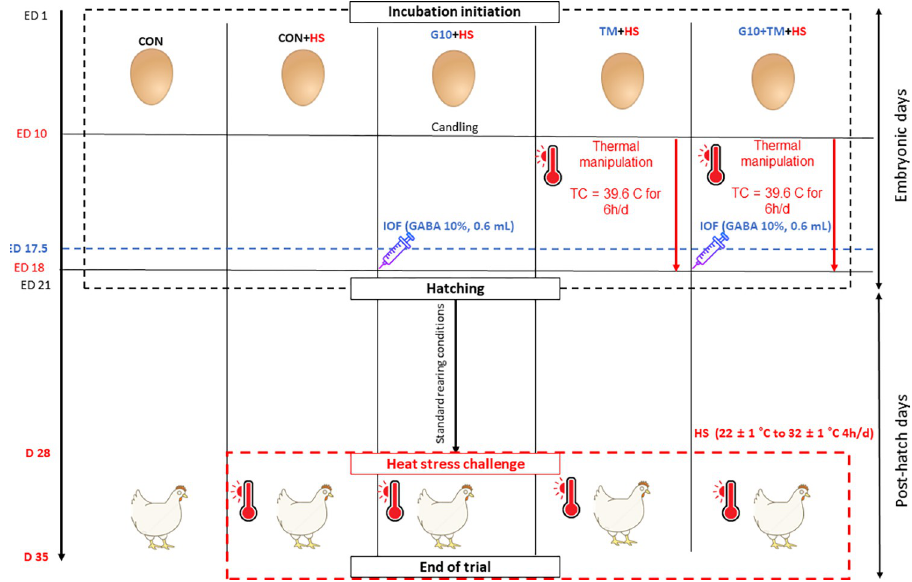
Fig 1. Study design. The treatments are described as follows: CON, chicks hatched from control eggs without in ovo injection and incubated at standard temperature; CON+HS, chicks hatched from control eggs without in ovo injection, incubated at standard temperature but exposed to HS; G10+HS, chicks hatched from eggs injected at 17.5 days of incubation with 0.6mL of 10% GABA dissolved in distilled water and exposed to HS; TM+HS, chicks hatched from thermally manipulated eggs exposed to 39.6˚C for 6 h daily from ED 10 to 18 and exposed to HS; G10+TM+HS, chicks, hatched from eggs that received both previous treatments during incubation, and exposed to